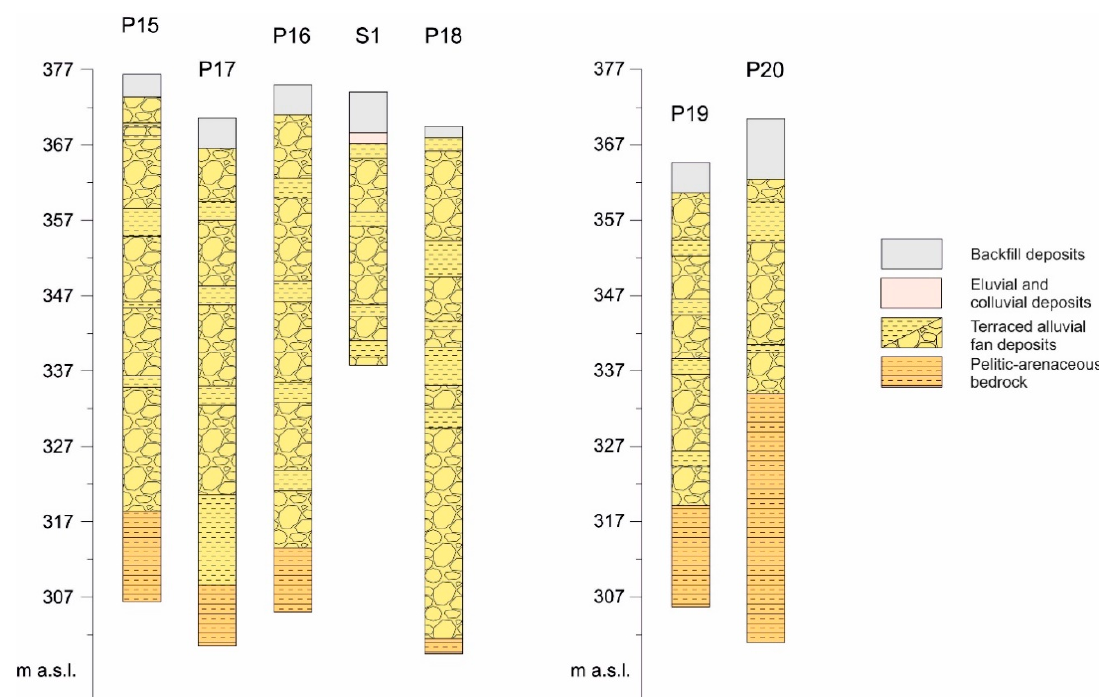
Figure 13. Borehole stratigraphy of the Castelnuovo area (location in Figure 14).